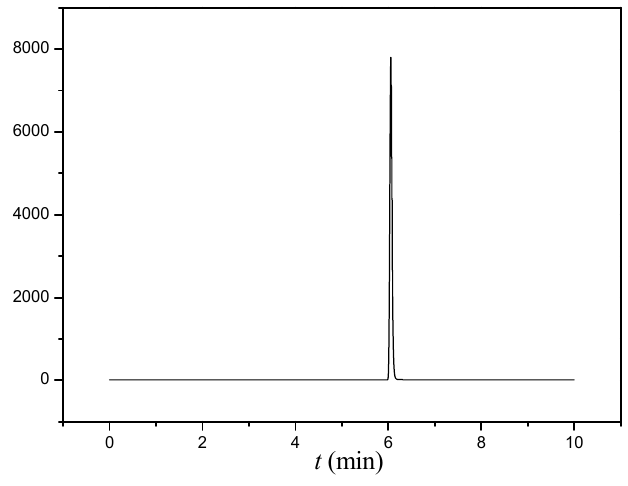
Figure 6. Chromatogram of 470 ppmv acetone in air.